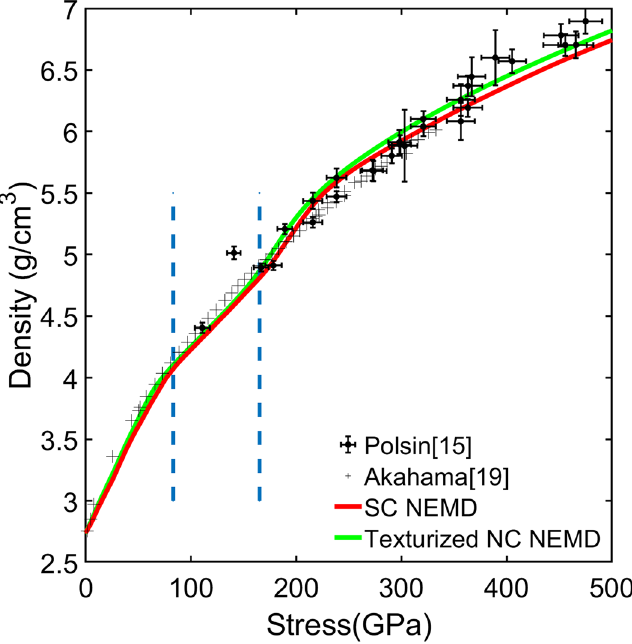
Figure 1. Density–stress curves for different simulation setups. The data are compared with ramp experiment from Ref. 15 and diamond anvil cell data from Ref. 19 . For both the simulation data and experiment data, the stress and density refers to the average stress and density throughout the thickness of the entire Al domain as a function of time, which will be referred to as the global stress and density for the rest of the paper. The first vertical dashed bar denotes the pressure onset for 100% bcc in SC NEMD. In between the two vertical dashed bars, the structure is full bcc and deforming elastically for SC NEMD. After the second dashed bars, defect growth is observed in SC